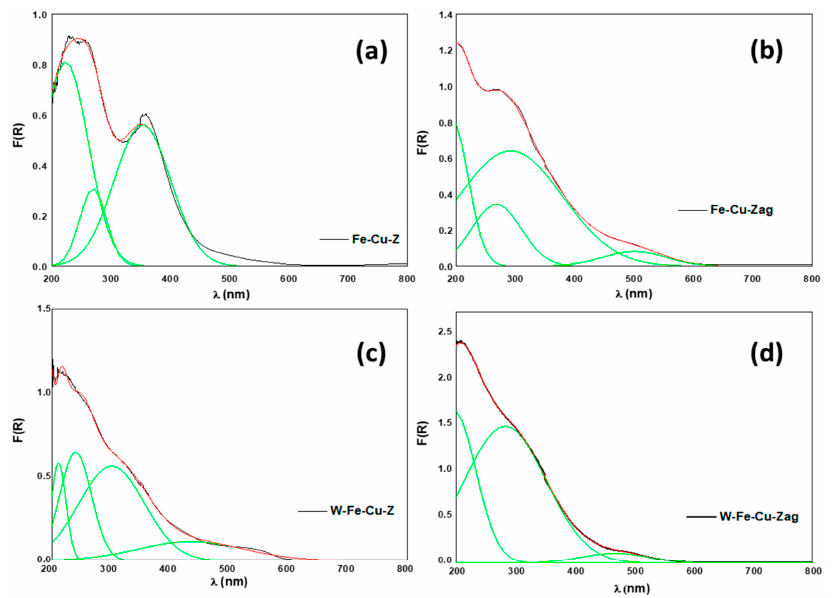
Figure 7. DRS UV-vis spectra of ( a ) Fe-Cu-Z, ( b ) Fe-Cu-Zag, ( c ) W-Fe-Cu-Z, and ( d ) W-Fe-Cu- Zag catalysts. Table 3. Assignment of the different UV-Vis bands according to the literature.